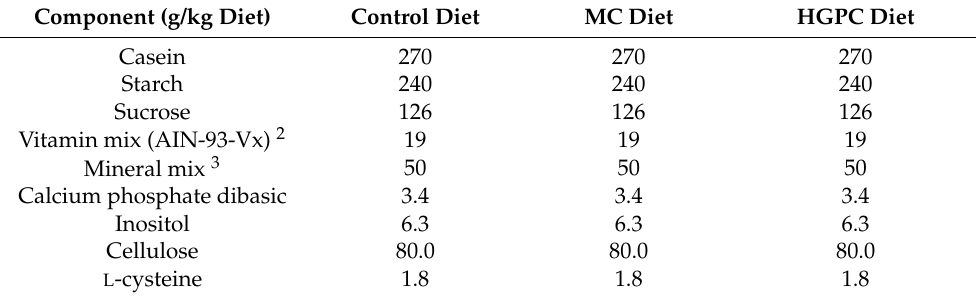
Table 1. Composition of experimental diets 1